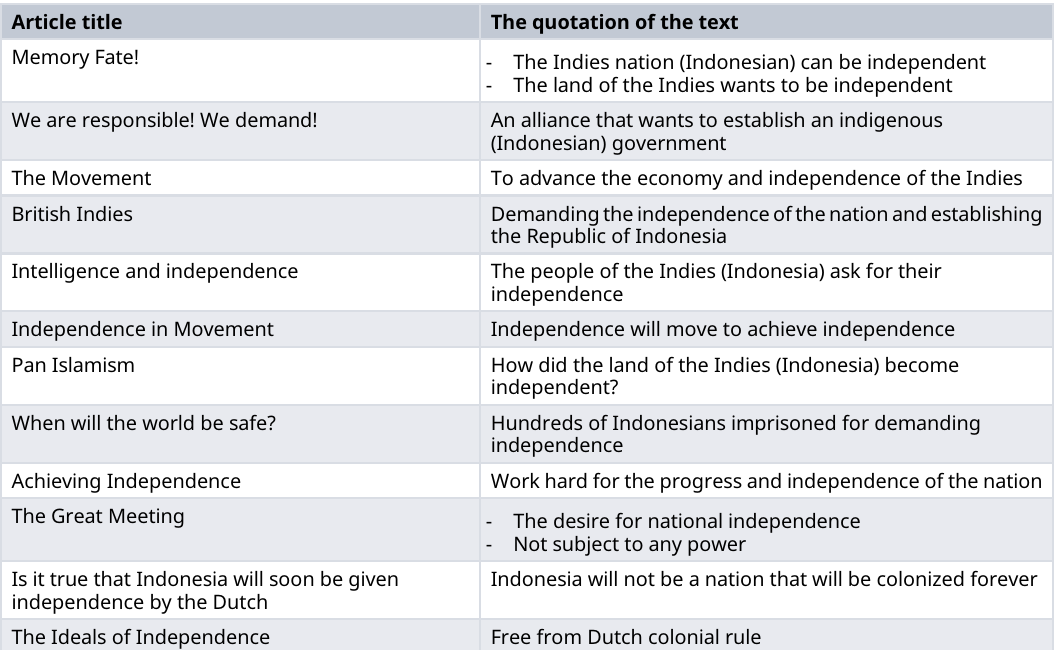
The quotation of the